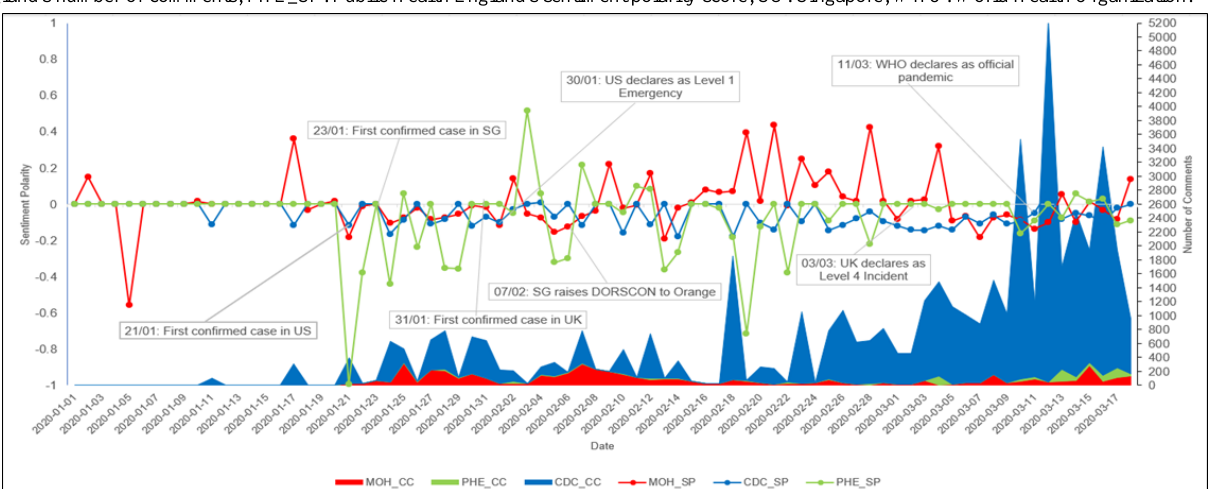
Figure 3. Temporal trend analysis for the number of comments and sentiment polarity. CDC_CC: Centers for Disease Control and Prevention's number of comments; CDC_SP: Centers for Disease Control and Prevention's sentiment polarity score; DORSCON: Disease Outbreak Response System Condition; MOH_CC: Ministry of Health's number of comments; MOH_SP: Ministry of Health's sentiment polarity score; PHE_CC: Pubilc Health England's number of comments; PHE_SP: Public Health England's sentiment polarity score; SG: Singapore; WHO: World Health